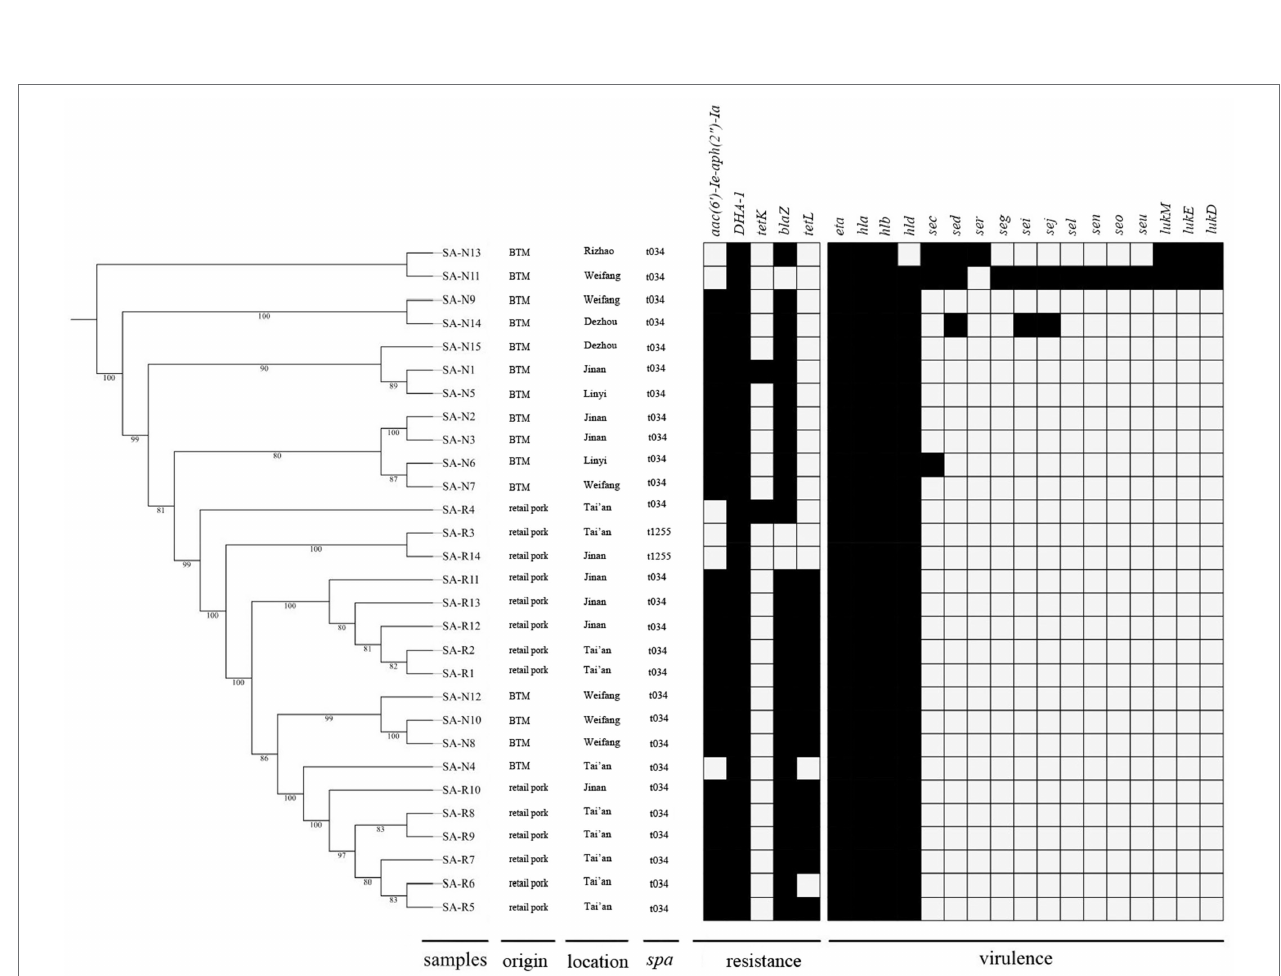
FIGURE 1 | Minimum Spanning Tree based on the MLST data for each isolate. Numbers indicate ST of each node.